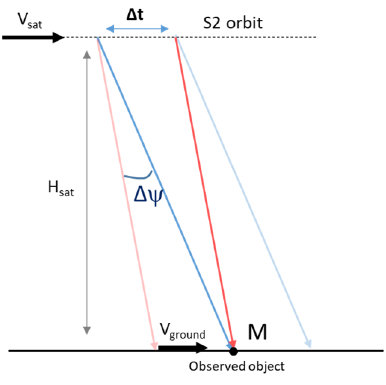
Figure 2 : Pushbroom interband